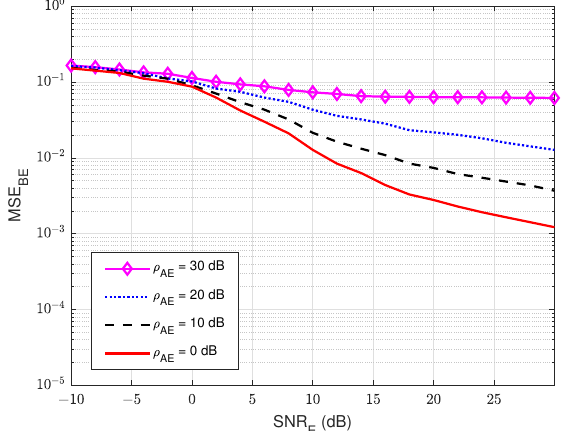
Figure 9. MSE BE versus SNR E in case of passive eavesdropper.